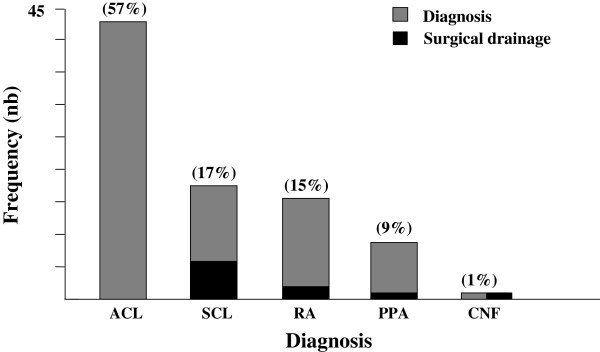
Frequency of diagnoses and surgical drainage. ACL: acute cervical lymphadenitis; SCL: suppurative cervical lymphadenitis; RA: retropharyngeal abscess; PPA: poststyloid parapharyngeal abscess; CHF: cervical necrotizing fasciitis. Percentages are given in parentheses.